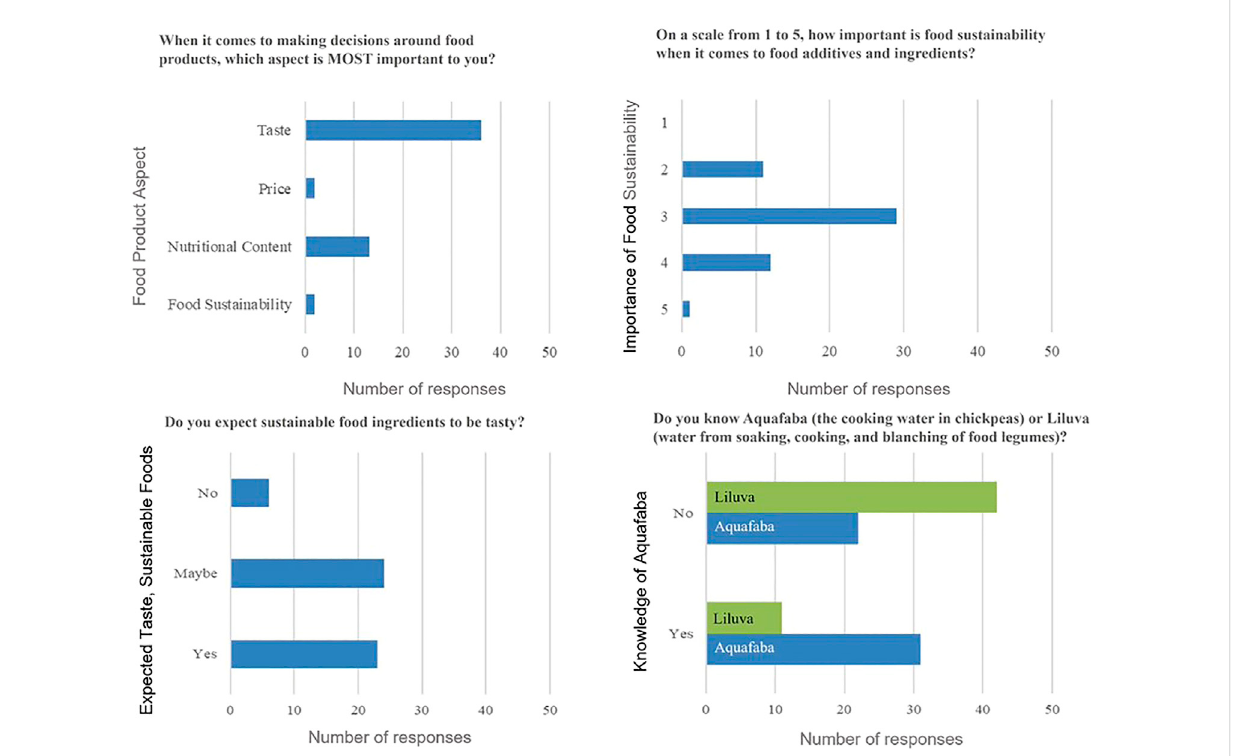
FIGURE 1 Response from focus group panelists to questions related to food sustainability: “ When it comes to making decisions around food products, which aspectisMOSTimportanttoyou? ” , “ Onascalefrom1to5,howimportantisfoodsustainabilitywhenitcomestofoodadditivesandingredients? ” , “ Doyou expectsustainablefoodingredientstobetasty? ” ,and “ Doyouknowaquafaba(thecookingwaterinchickpeas)orliluva(waterfromsoaking,cooking,and blanching of food legumes)? ”